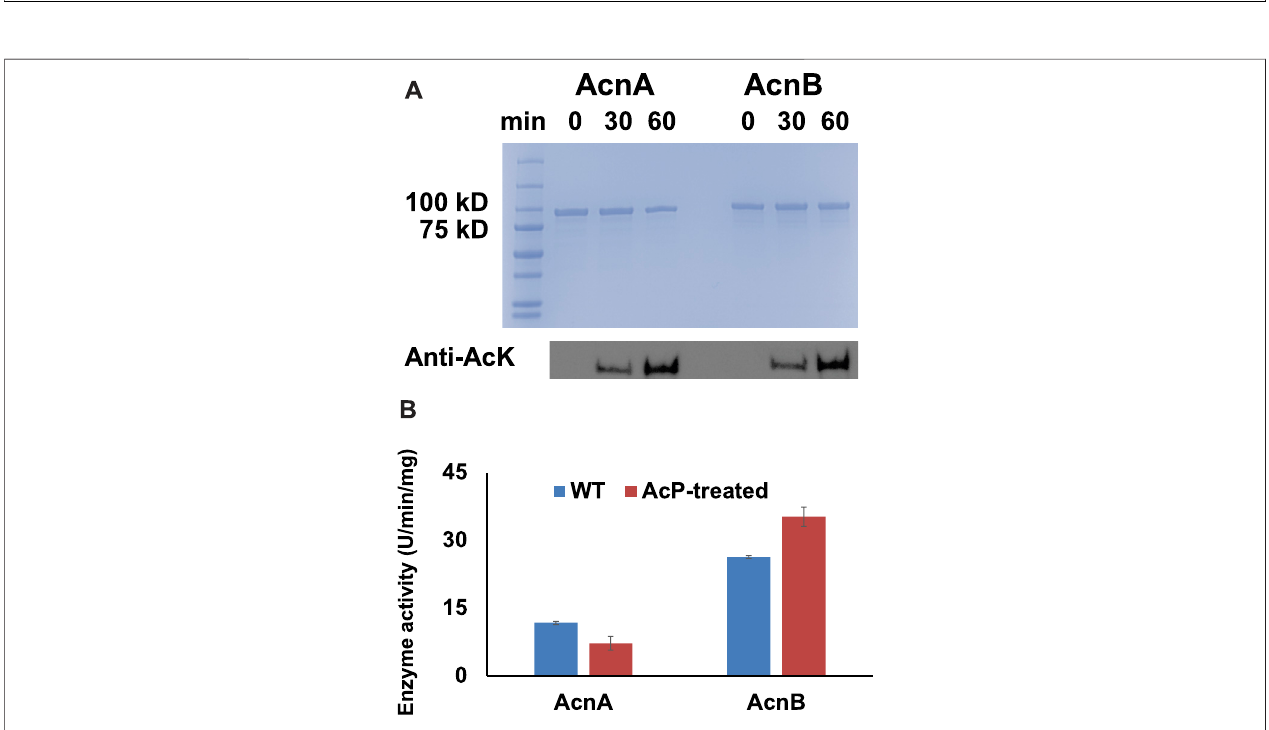
FIGURE 2 | AcP-dependent acetylation of AcnA and AcnB. (A) SDS-PAGE and wester blots of puri fi ed WT AcnA and WT AcnB treated with AcP in vitro . 2 µg of proteinswereloadedforeachlane.Thefullimageofwesternblotsisin SupplementaryFigureS16 . (B) Enzymeactivitiesofpuri fi edWTAcnAandWTAcnBbeforeand after AcP-treatment. Mean values and standard deviations were calculated based on three replicates. The Student ’ s t test was used to analyze the signi fi cance of differences between activities of enzymes before and after AcP-treatment.